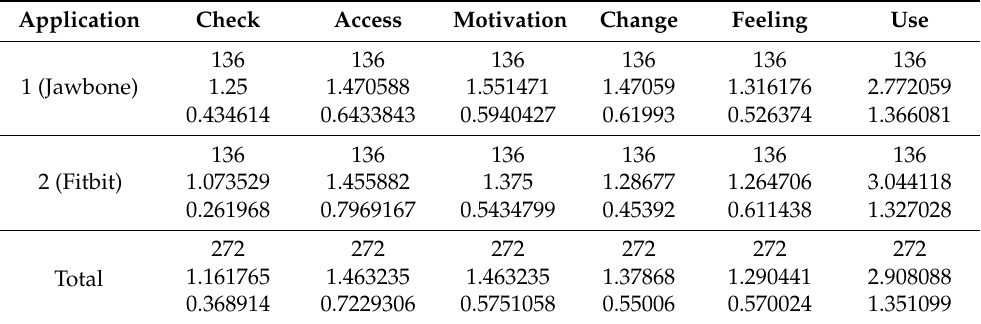
Table 2. Means and standard deviations of diary study participants questions by application ( n = 34, Observations = 272, 8 time periods, 2 applications).